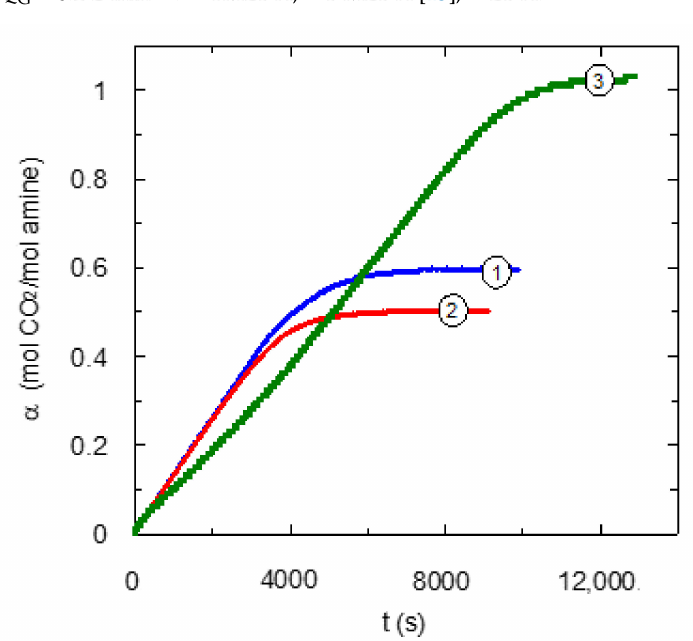
Figure 6. Effect of type of center of amino centers upon carbon dioxide loading. C B = 0.6 mol · L − 1 . Q G = 0.2 L · min − 1 . 1 (cid:13) EDA; 2 (cid:13) DMEDA [13]; 3 (cid:13) TMEDA. The carbon dioxide loading has been calculated per mol of amino